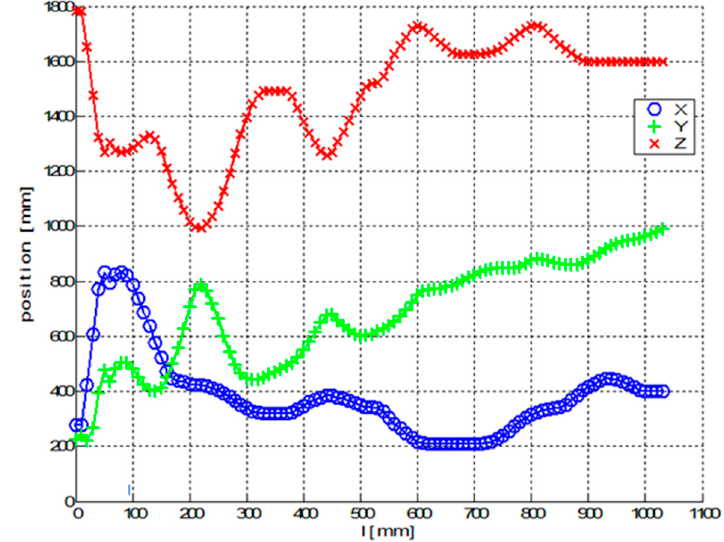
Figure 24. Test 2—Diagram of the optimal course of the TCP OPT during the passage of the frame through the fiber-processing head-values of the first three parameters of TCP OPT .